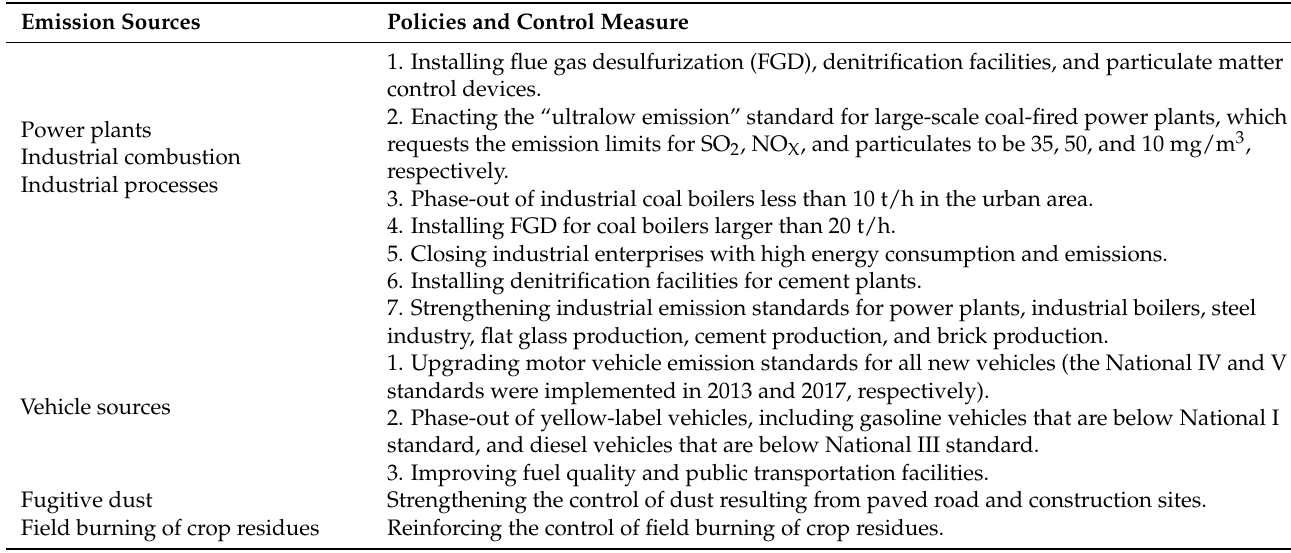
Table 1. Major policies and control measures implemented during 2013–2017 in Sichuan.